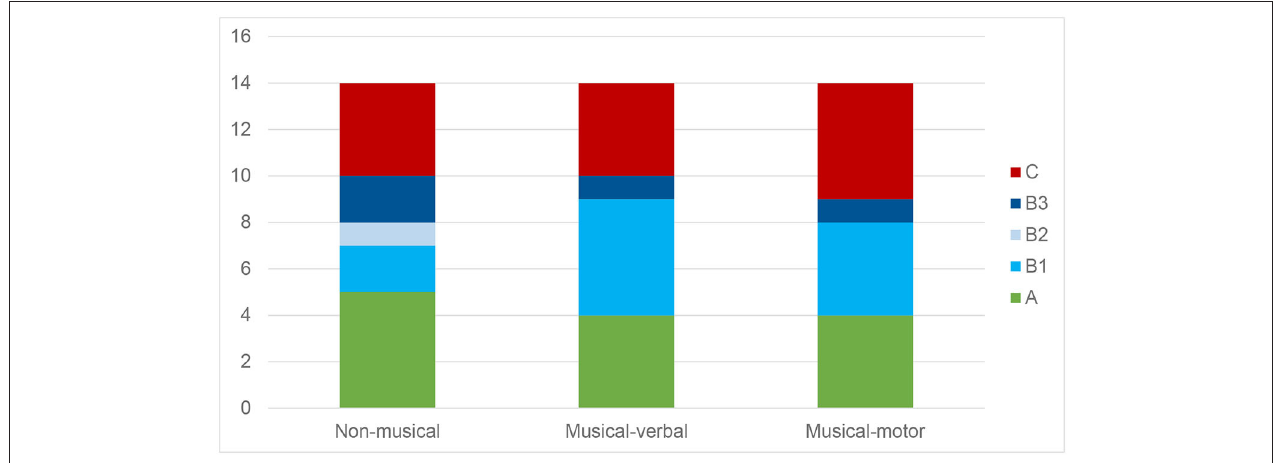
FIGURE 2 | Frequency of prosocial behavior in the three stimulation